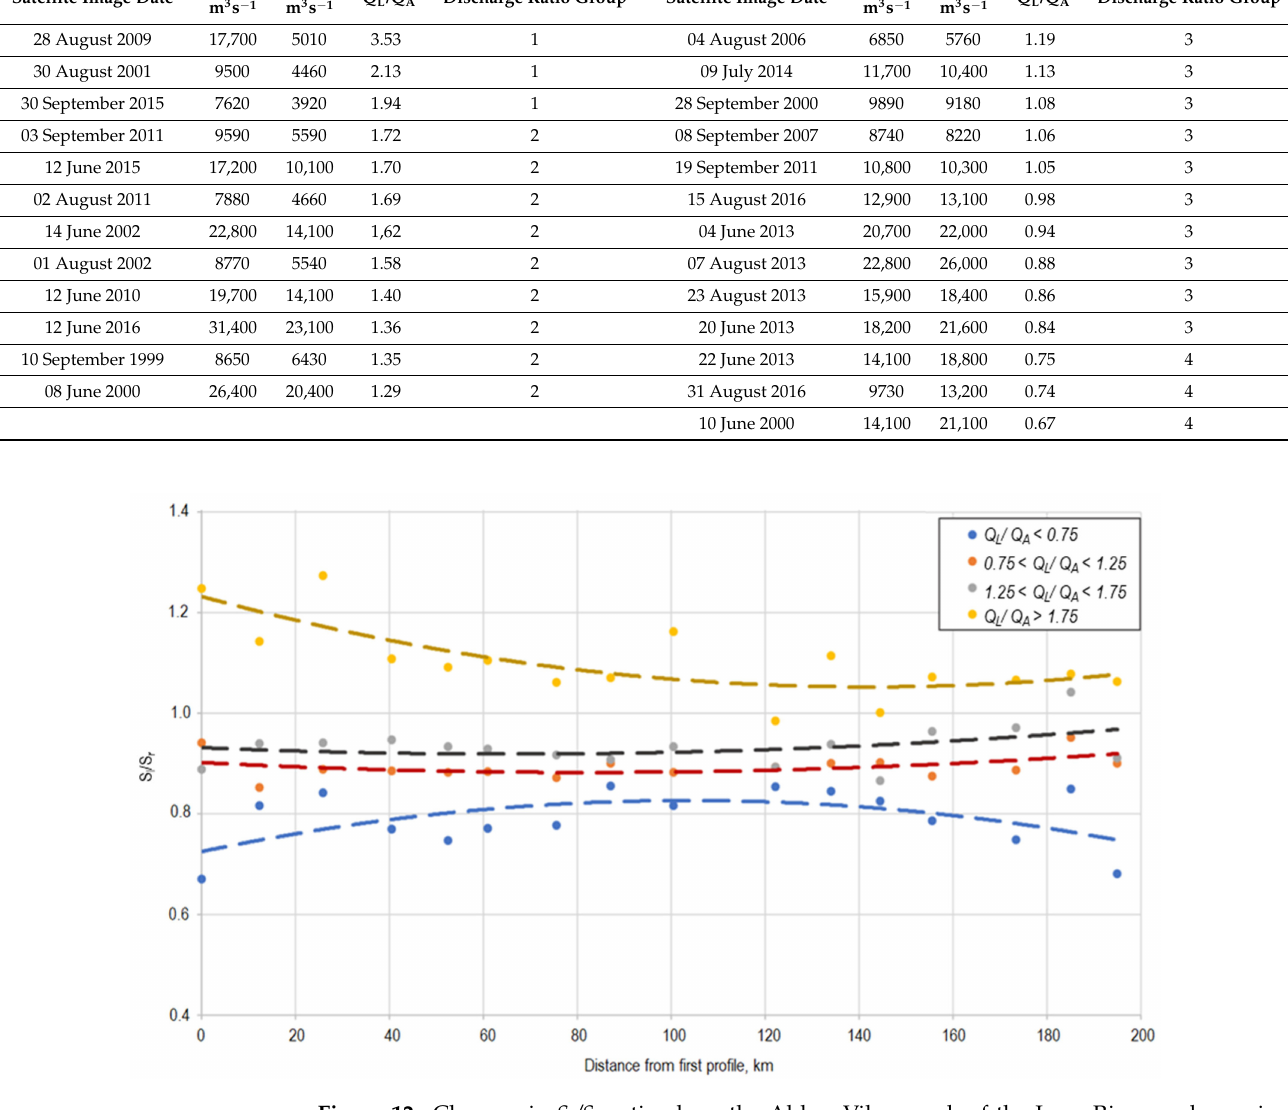
Figure 12. Changes in S l /S r ratio along the Aldan–Viluy reach of the Lena River under various hydrological conditions Q L /Q A